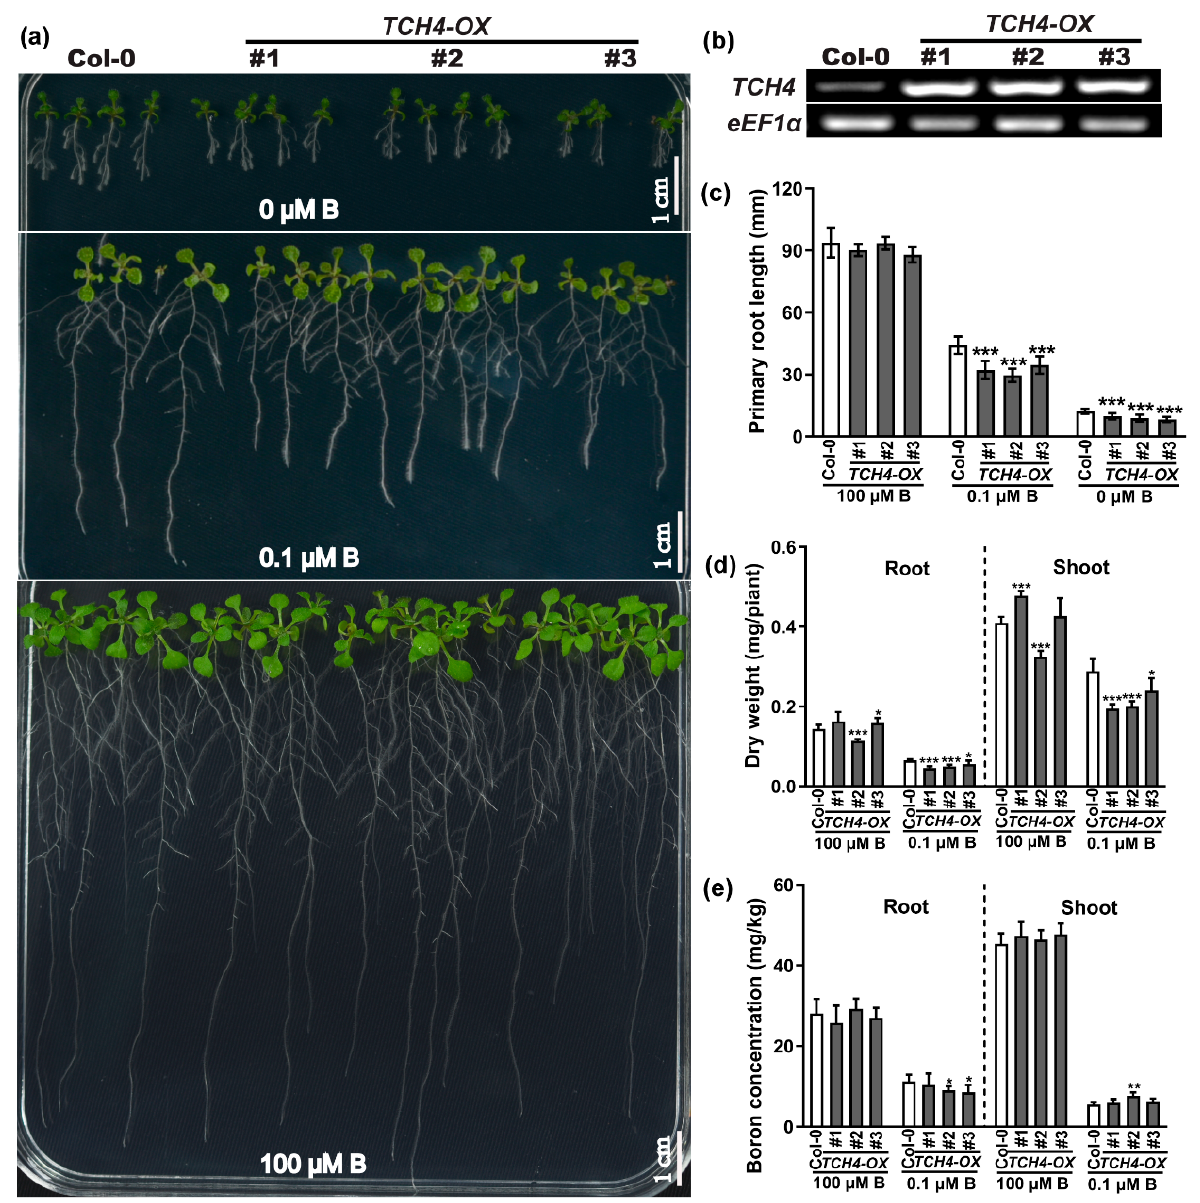
Figure 3. Phenotype of the TCH4 overexpression ( TCH4 - OX ) lines under different boron levels. ( a ) Phenotype of wild-type (Col-0) and TCH4 - OX lines grown under different B concentrations. Scale bar, 10 mm. ( b ) Analysis of TCH4 expression level by RT-PCR. ( c ) Primary root length of wild-type (Col-0) and TCH4 - OX lines grown as in ( a ) (mean ± s.d., n = 15). ( d ) Dry weight of wild-type (Col-0) and TCH4 - OX lines grown in media and supplemented with 0.1 and 100 μ M B for 10 days (mean ±